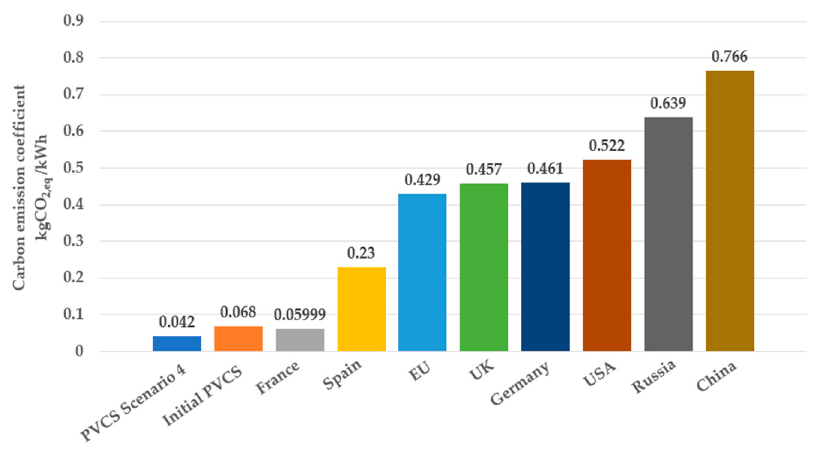
Figure 13. Comparison of the carbon emission coefficient of PVCS with the PGCS in different countries.